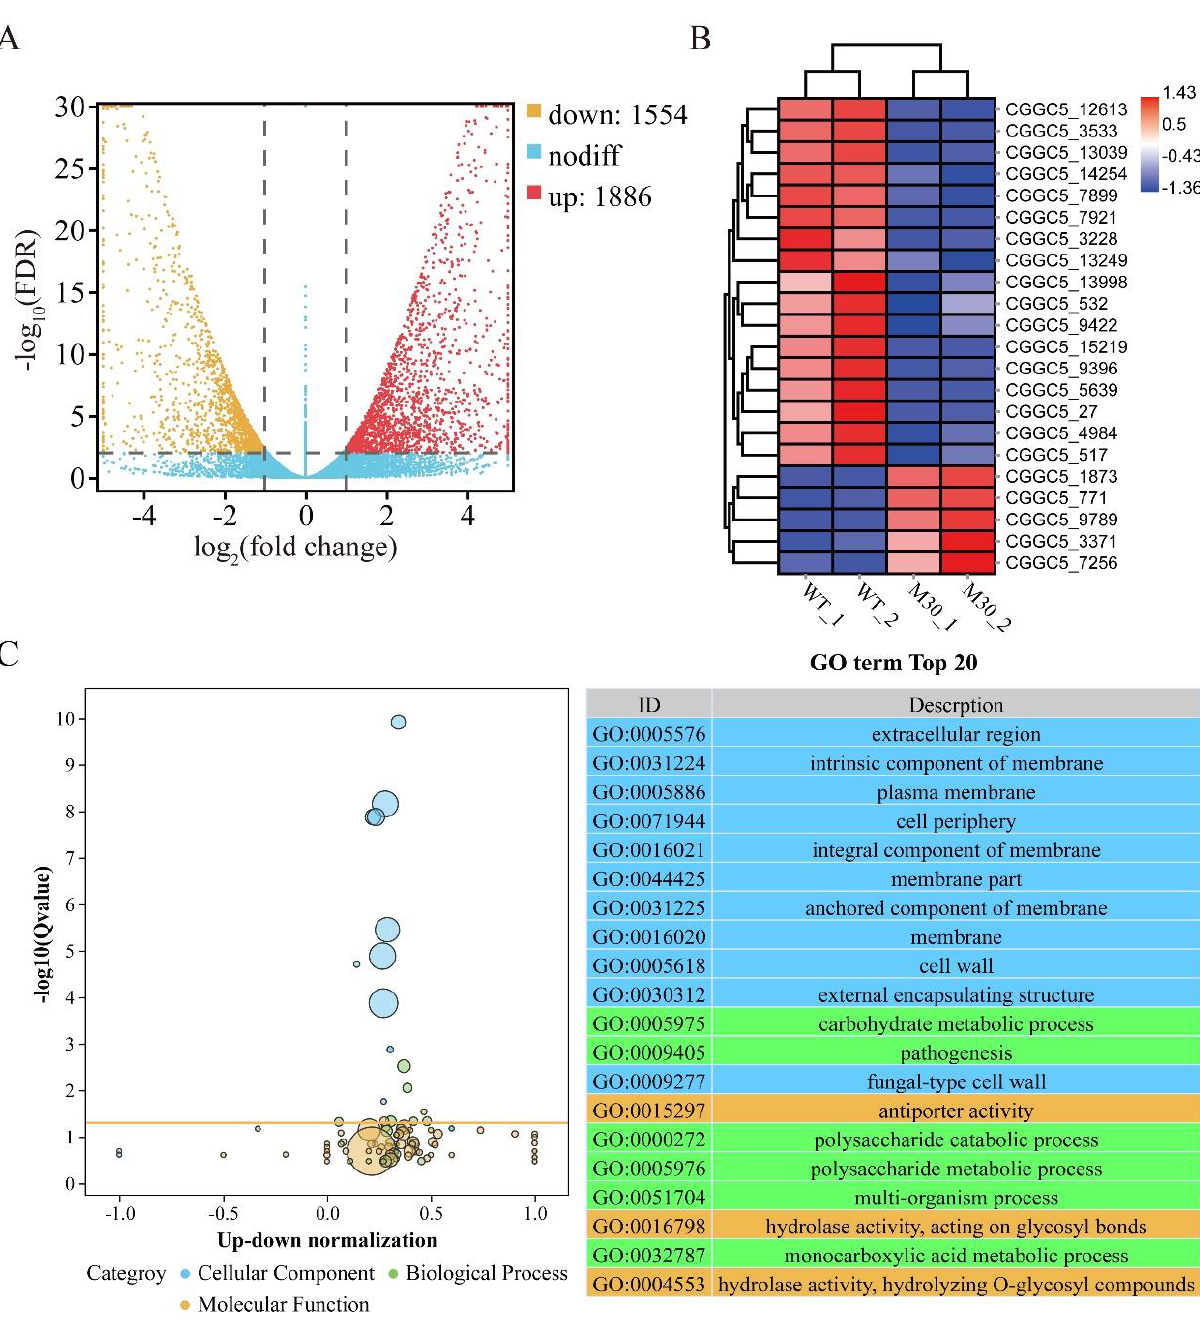
Figure 8. RNA-seq analysis of the Δ Cfmk1 mutant and WT strains. ( A ) Volcano plot of DEGs between the Cfmk1 mutant and WT. ( B ) Heat map showing the expression levels of 22 DEGs annotated to the MAPK signaling pathway. The color bars represent the values of log2-fold change ( Cfmk1 mutant vs. WT). ( C ) Significant GO analysis of DEGs. The top 20 terms are listed.